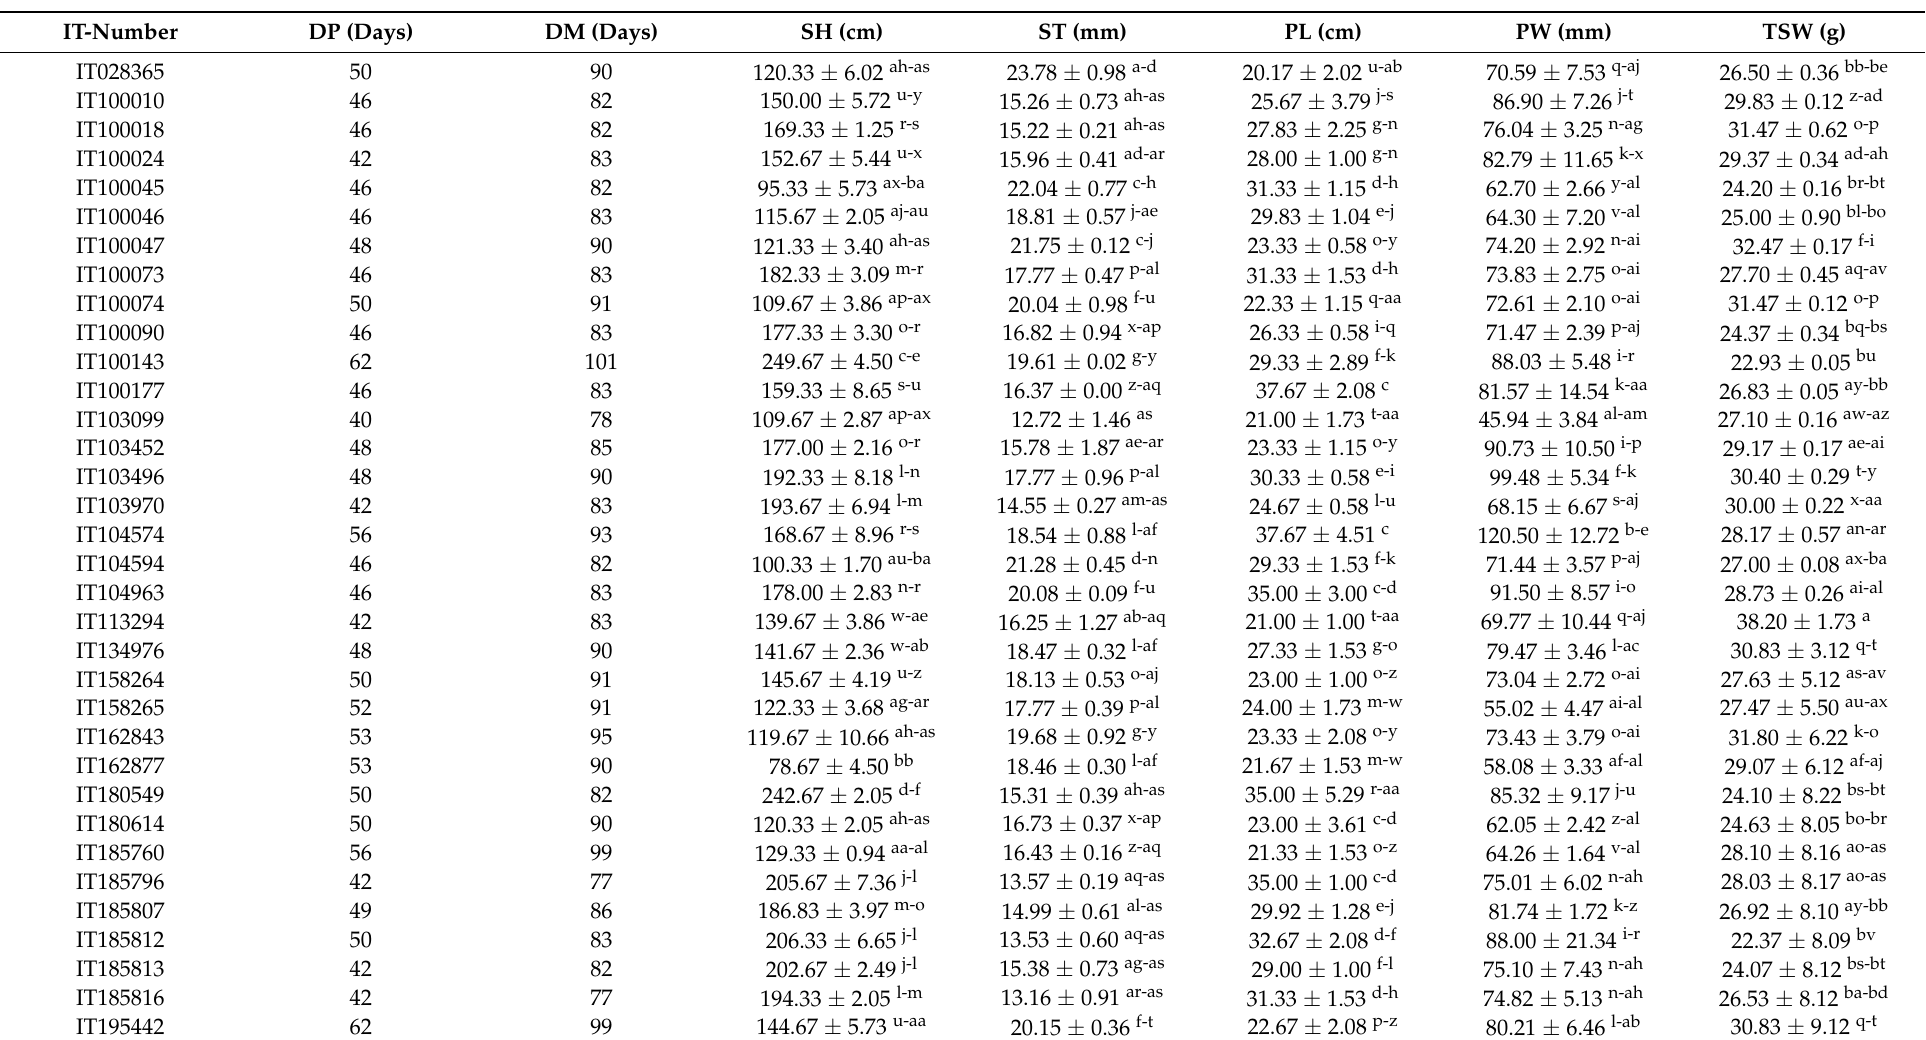
Table 1. Quantitative agronomic properties of sorghum genotypes cultivated in